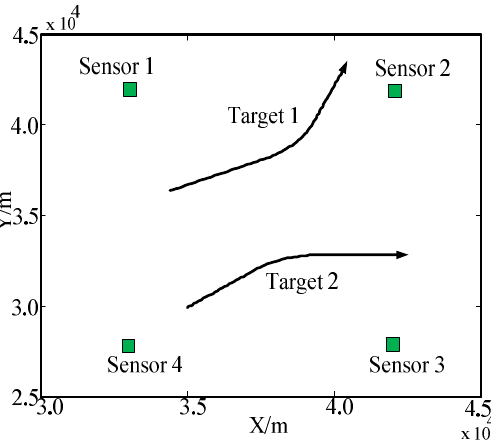
Figure 18. Sensor positions and target trajectories.